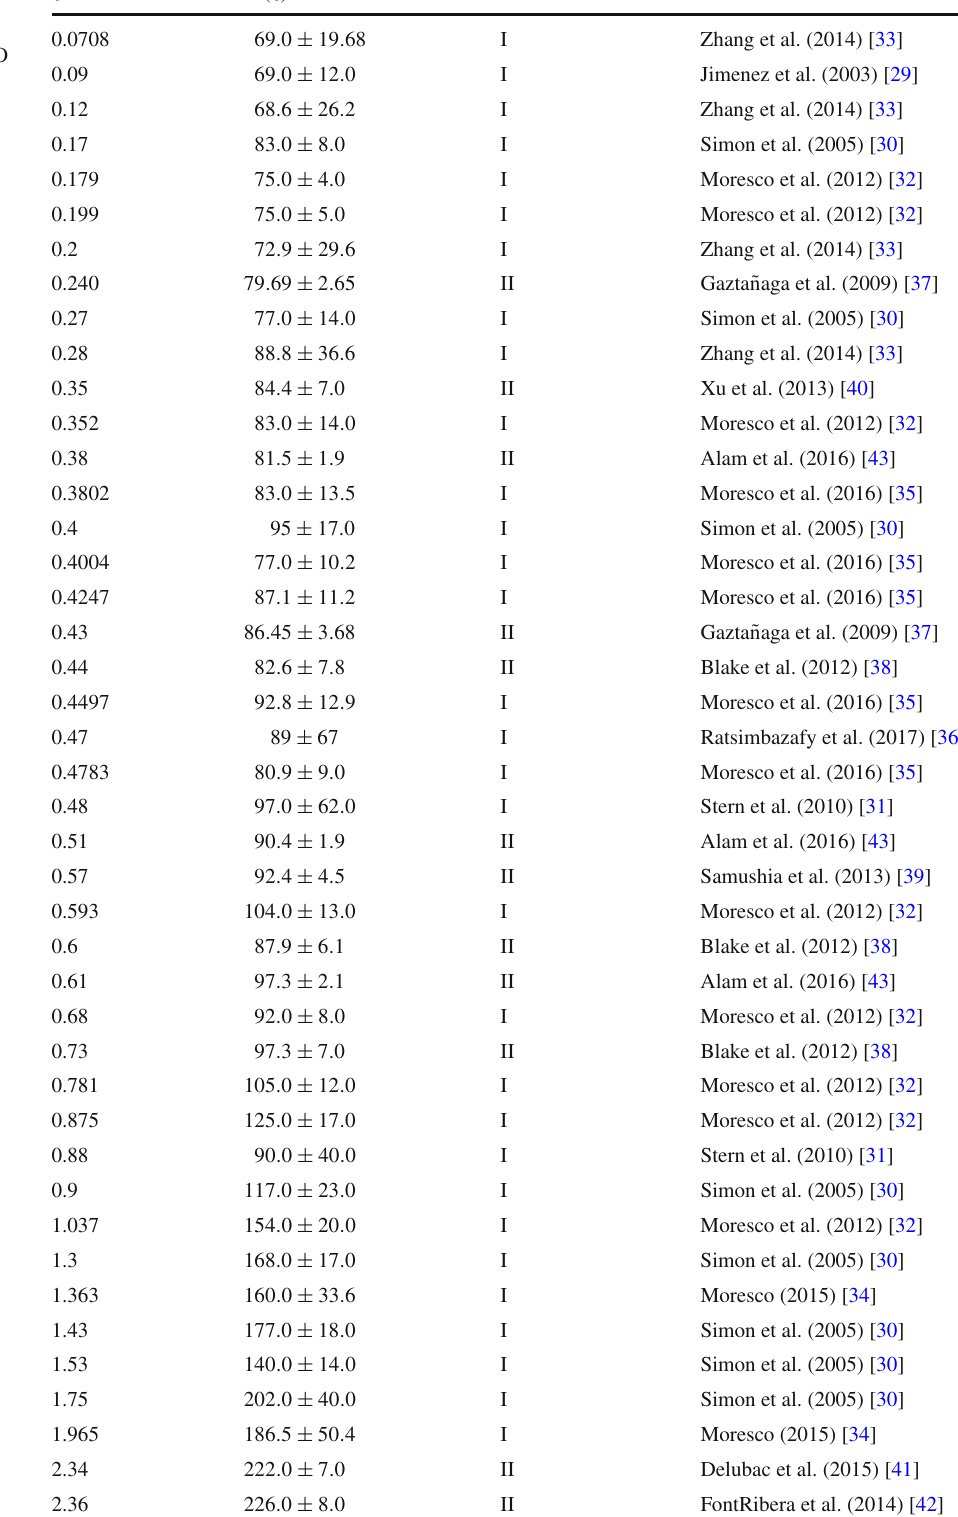
Table 1 The current available OHD dataset. Where I and II represent the cosmic chronometer and the radial BAO size method, respectively, and H ( z ) is in units of km s − 1 Mpc − 1